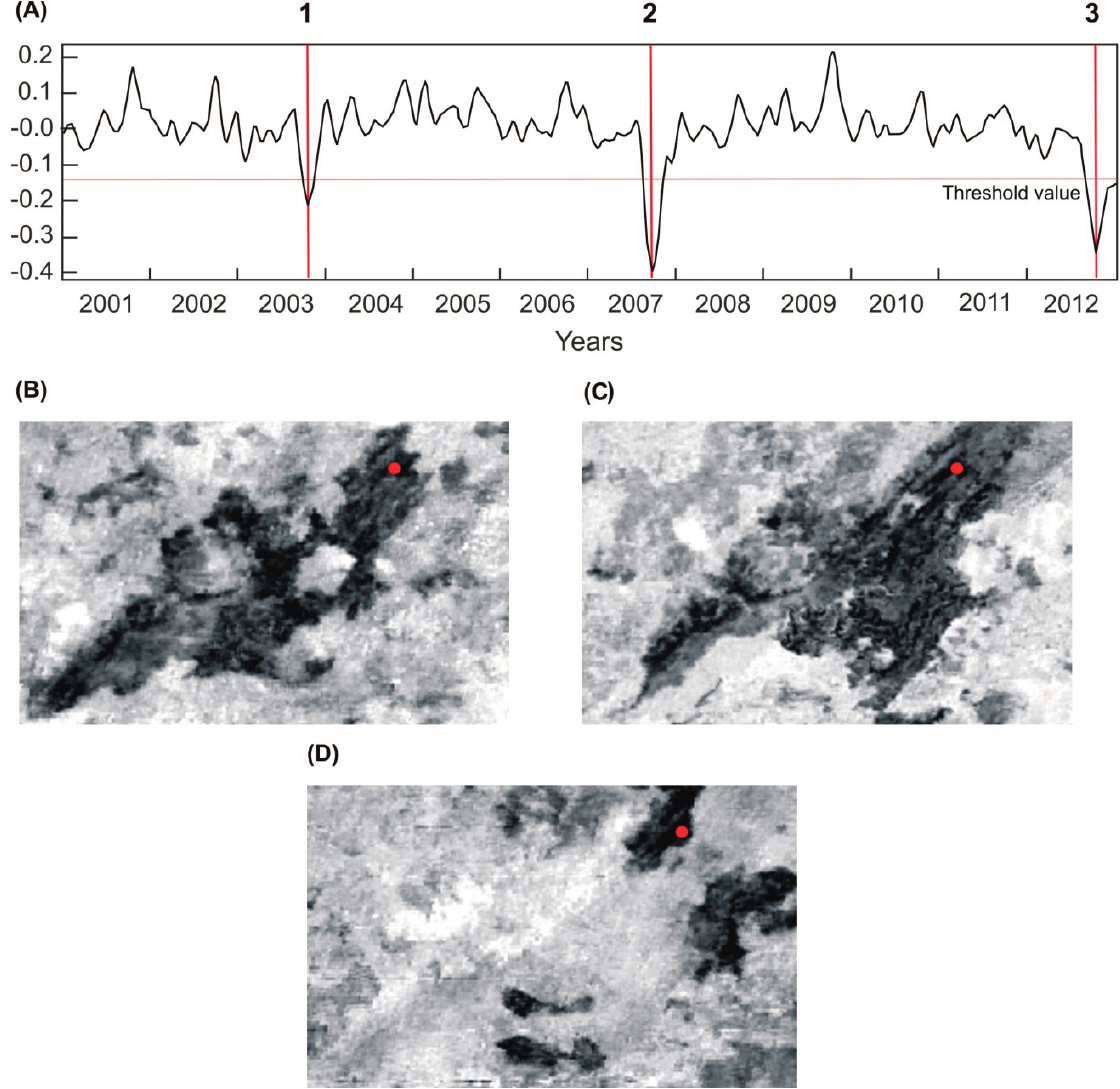
Figure 18. ( A ) Temporal curve of deviation from the trimmed mean interannual phenology (alpha = 0.1) with three negative anomalies of fire events; ( B ) deviation image acquired on Julian day 289 in 2003; ( C ) Julian day 281 in 2007; and ( D ) Julian day 281 in 2012. The red dot on the deviation images marks the location of the temporal